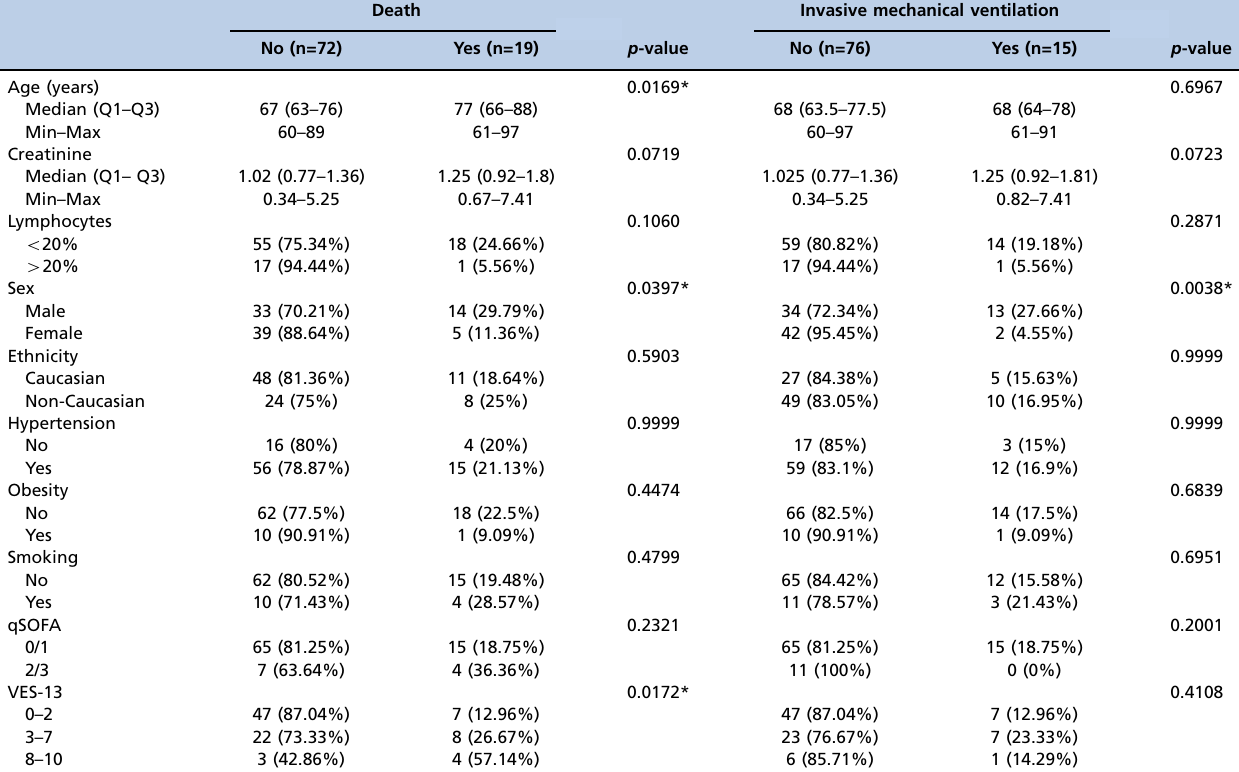
Table 1 - Description of patients, characteristics, and